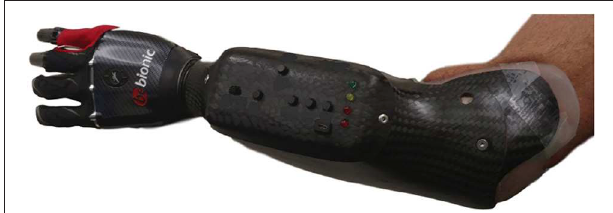
FIGURE 1 | Custom made prosthetic socket and the Bebionic 3 robotic